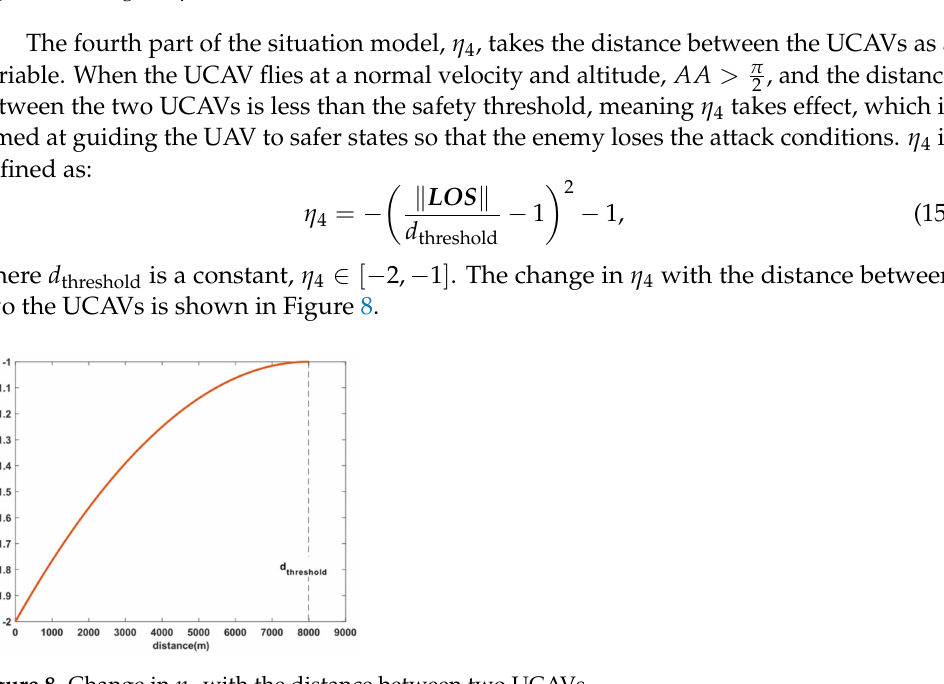
Figure 7. Change in η 3 with AA .